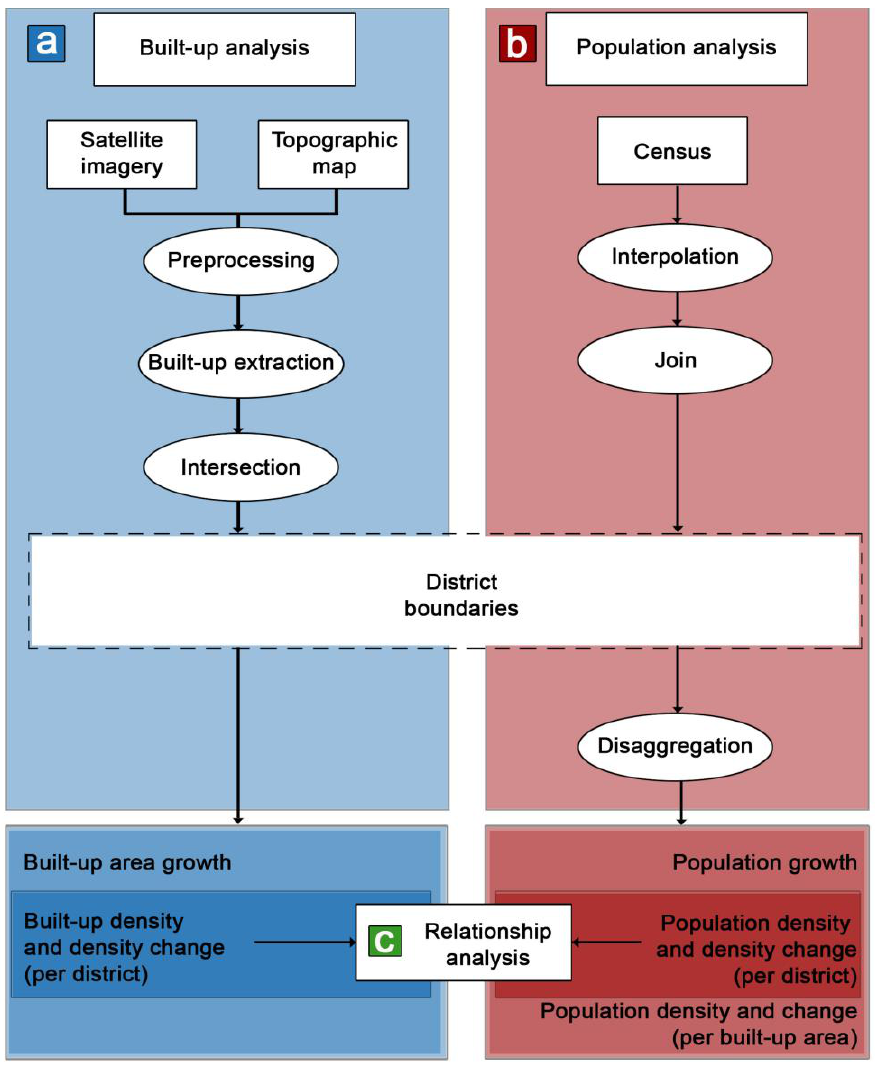
Figure 3. The processing and analysis workflow. ( a ) Delineation of built-up areas and change analysis. ( b ) Population distribution and change analysis. ( c ) Spatial population change analysis related to built-up